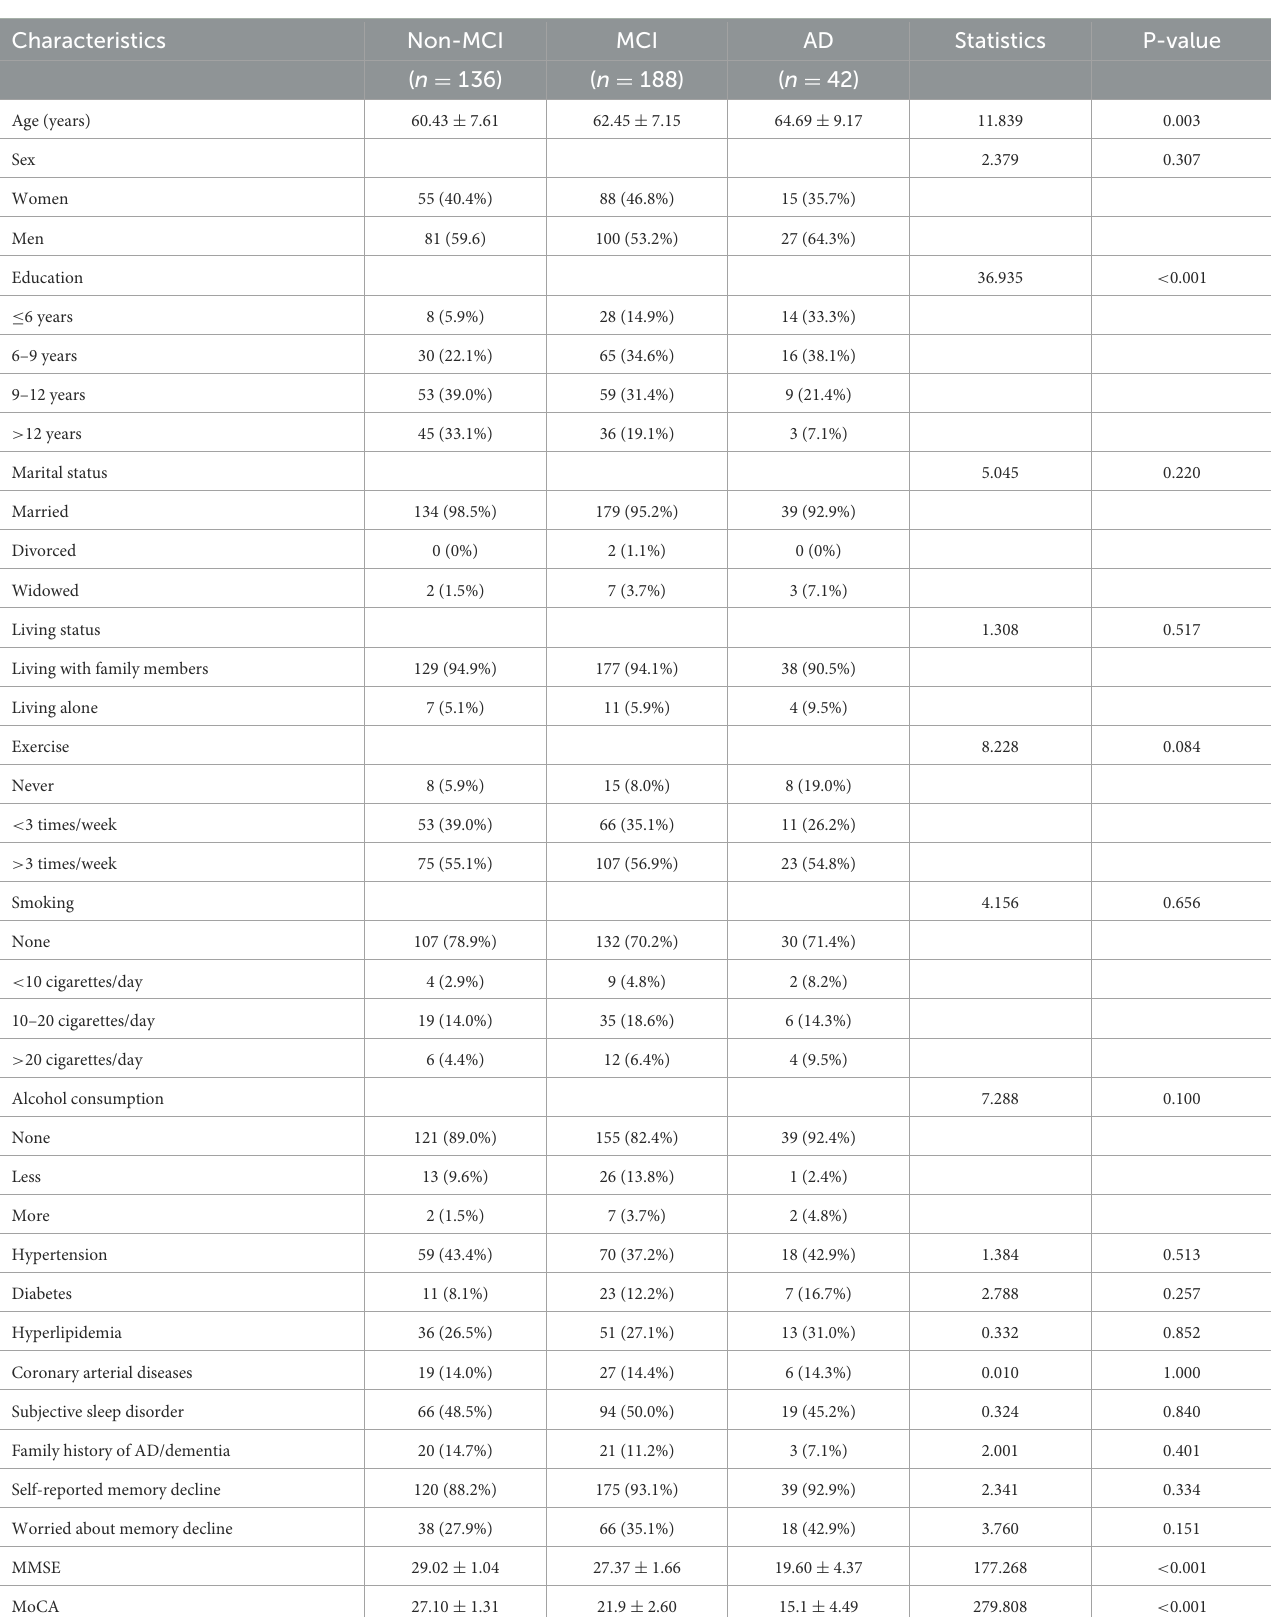
TABLE 1 Demographic characteristics of the